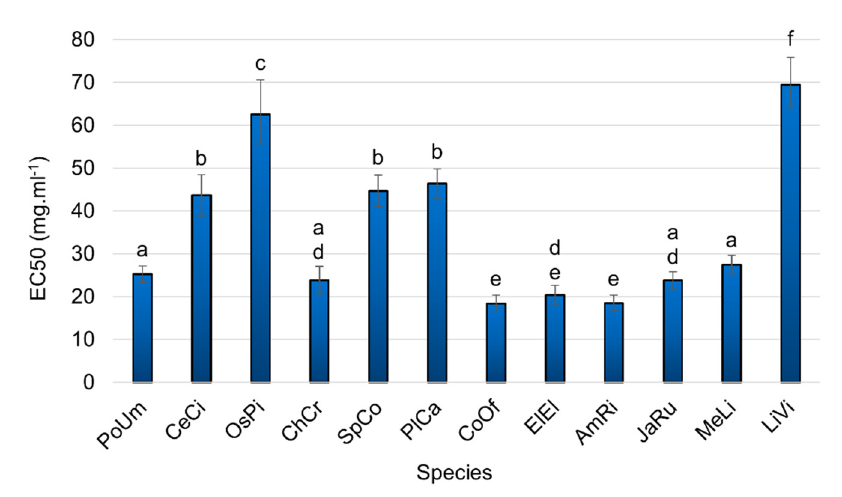
Figure 1. EC 50 of the ABTS results of the twelve studied red seaweed species expressed in mg · mL − 1 .